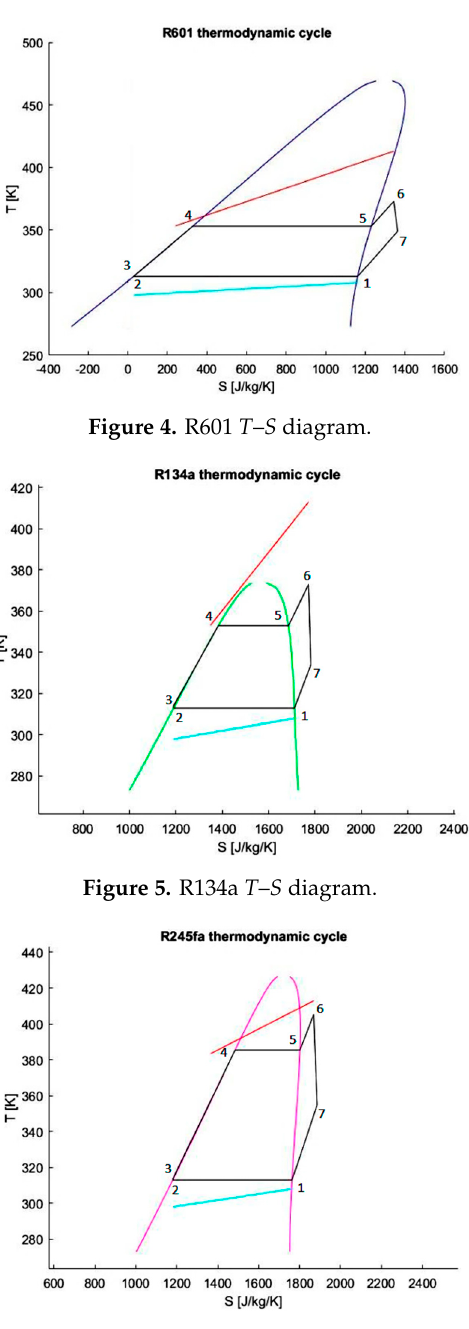
Figure 7. SES36 T – S diagram. Table 5. SES36 thermodynamic parameters. Equipment